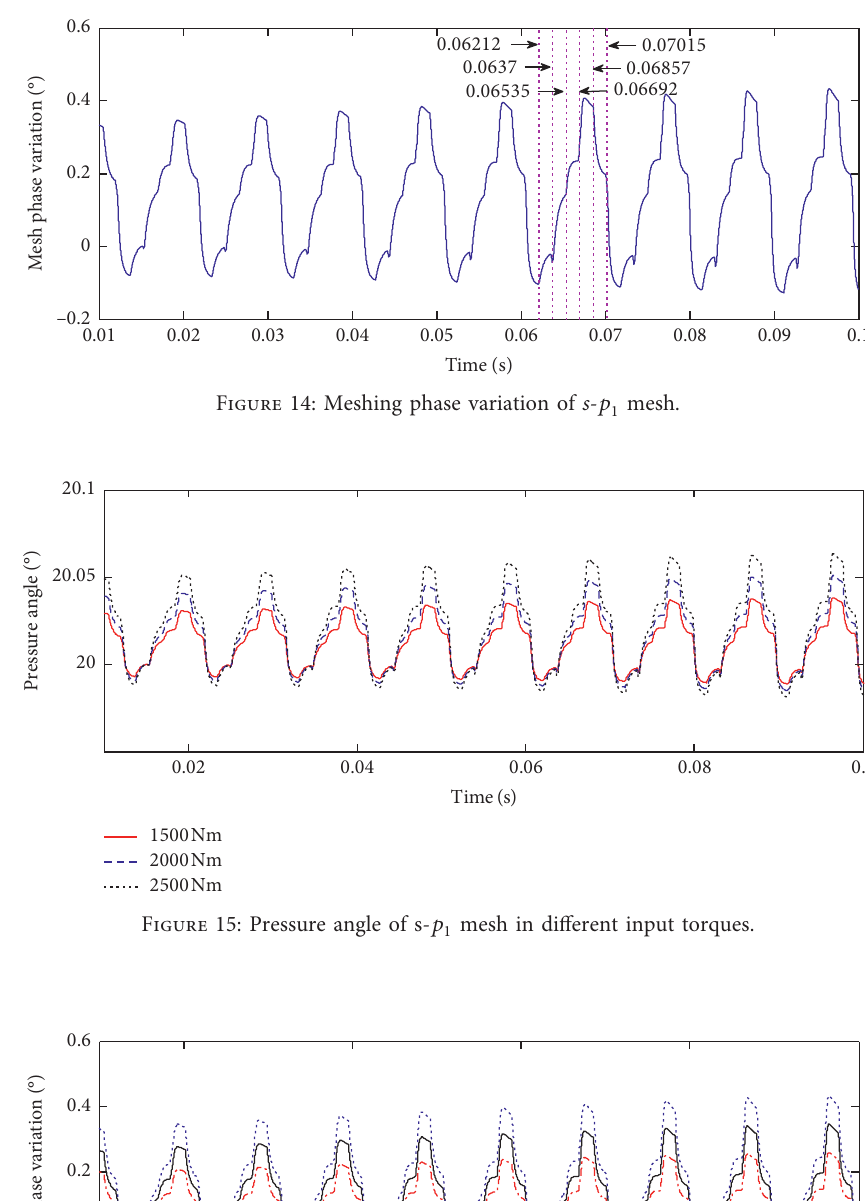
mesh in different input torques. 1